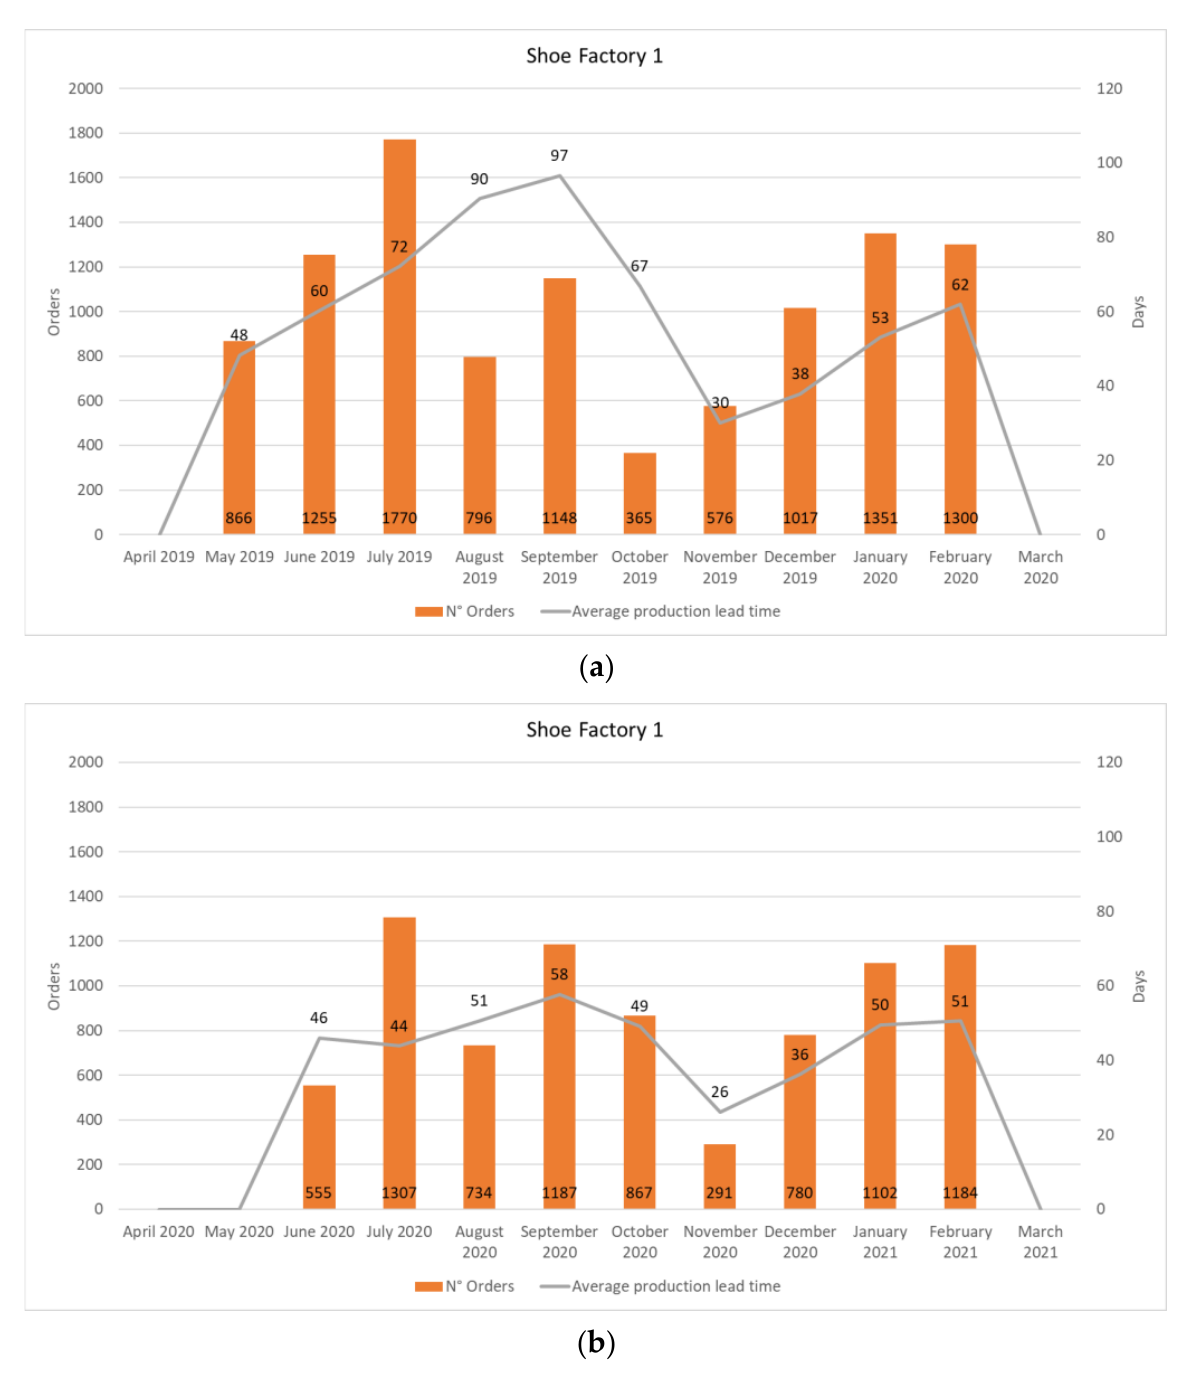
Figure 2. Shoe factories — seasonal N° of pairs, N° of orders, and average production lead time of SF1 ( a ) and SF2 ( b ).